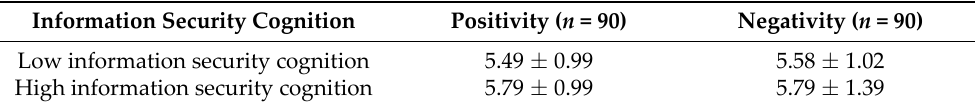
Table 14. Mean Comparison of Information Security Cognition and Nature. (Mean ± Standard Deviation).